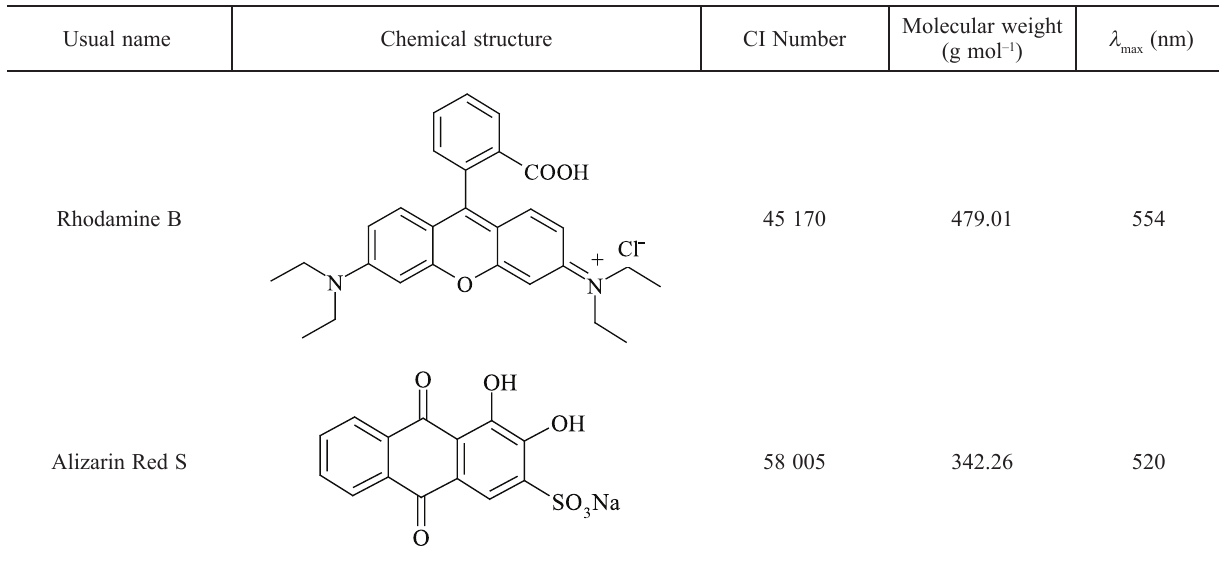
Table 1 – Data of Rhodamine B and Alizarin Red S as studied